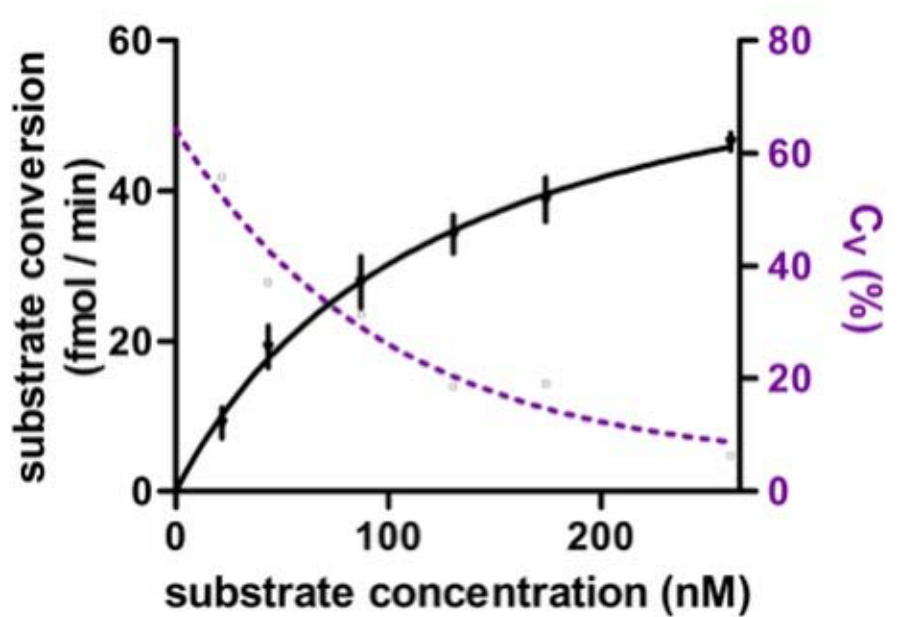
Figure 3. Steady-state kinetics. The mean K M was 123 nM (SEM = 27.9%; 95% CI: 60–186 nM). Calculation of K M and V MAX values showed high variability (C V (K M ) = 65.7%; C V (V MAX ) = 24.5%), Figure 3. Steady ‐ state kinetics. The mean K was 123 nM (SEM = 27.9%; 95% CI: 60–186 nM). M while the C V of individual measurements was dependent on the substrate concentration. RNase H2 activity at a substrate concentration of 235 nM (>2 SD above K M ) was associated with a C V below Calculation of K and V values showed high variability (C (K ) = 65.7%; C (V ) = 24.5%), M MAX V M V MAX 10% and implemented as assay endpoint; mean ± SD is